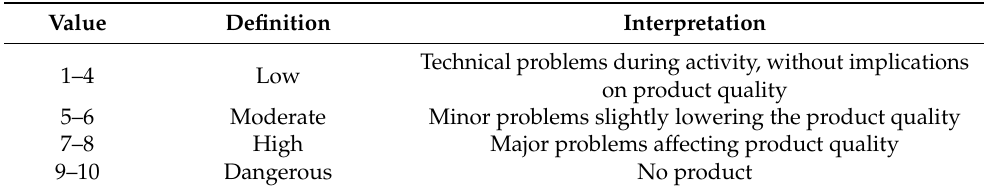
Table 2. Severity scale. The four groups correlate with the increased bad potential effect of the considered failure modes.